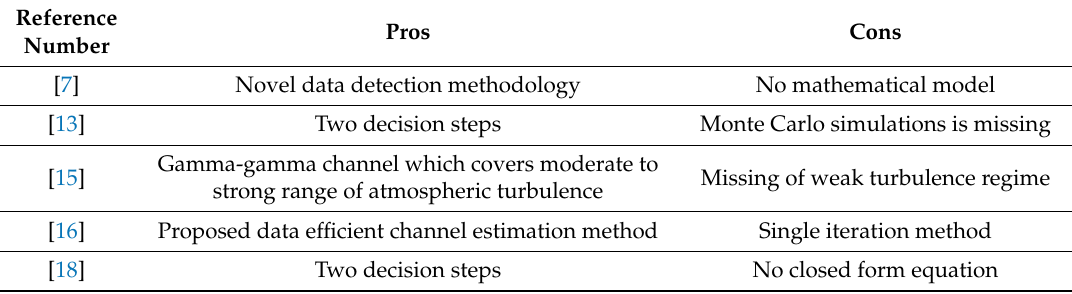
Table 1. Pros and cons of Free-space optical (FSO) blind detection papers in the literature.